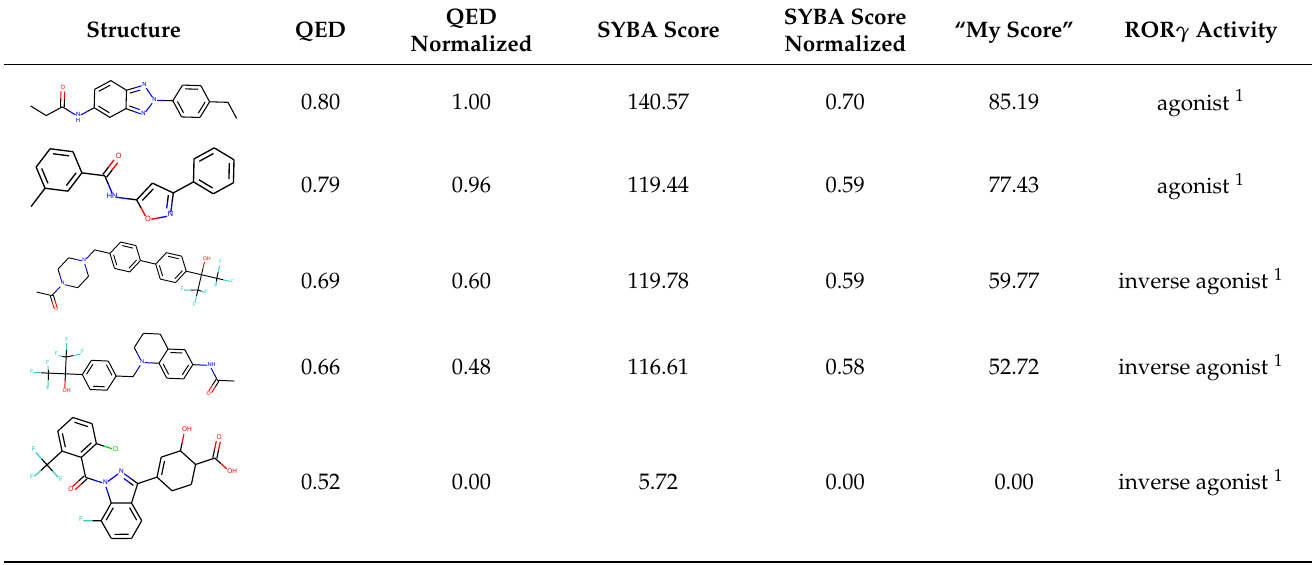
Table 5. These structures were used as prediction